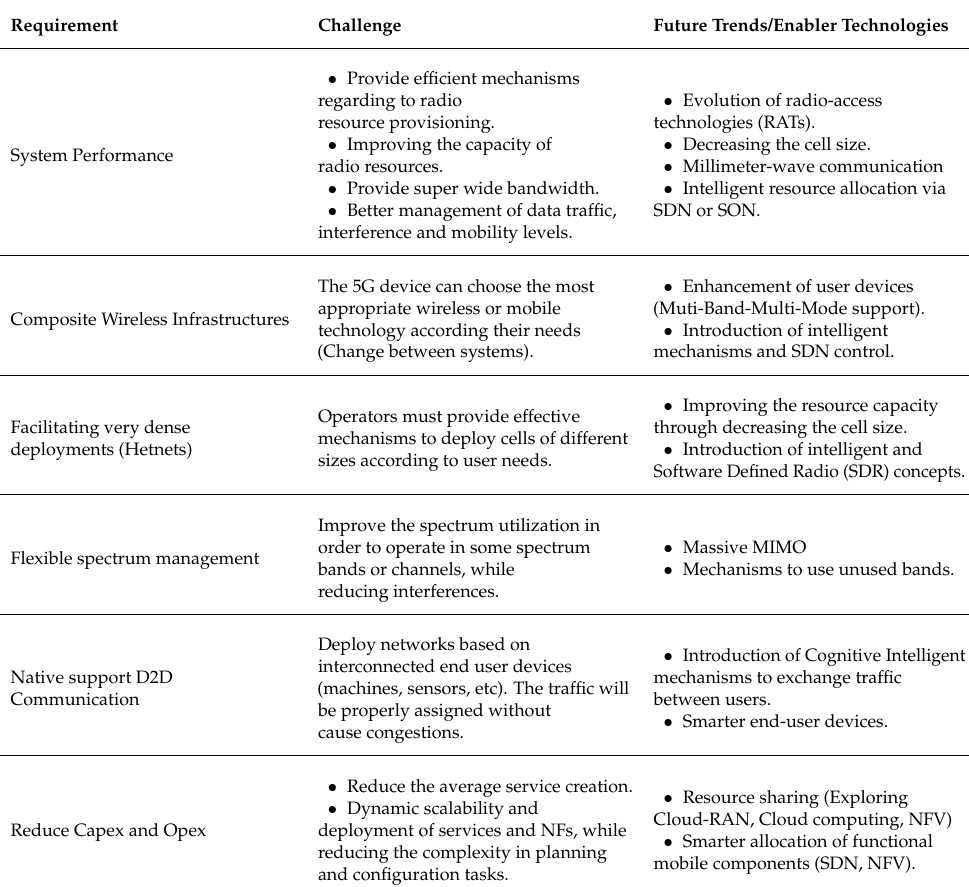
Table 2. Current Trends and